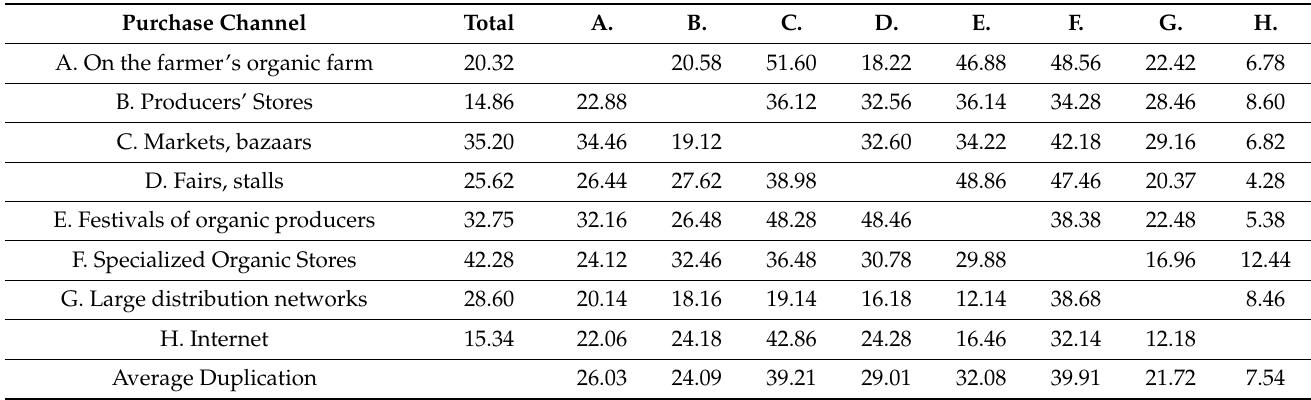
Table 3. Duplicating purchases between the selected purchase channels for organic products among consumers. Purchase Channel